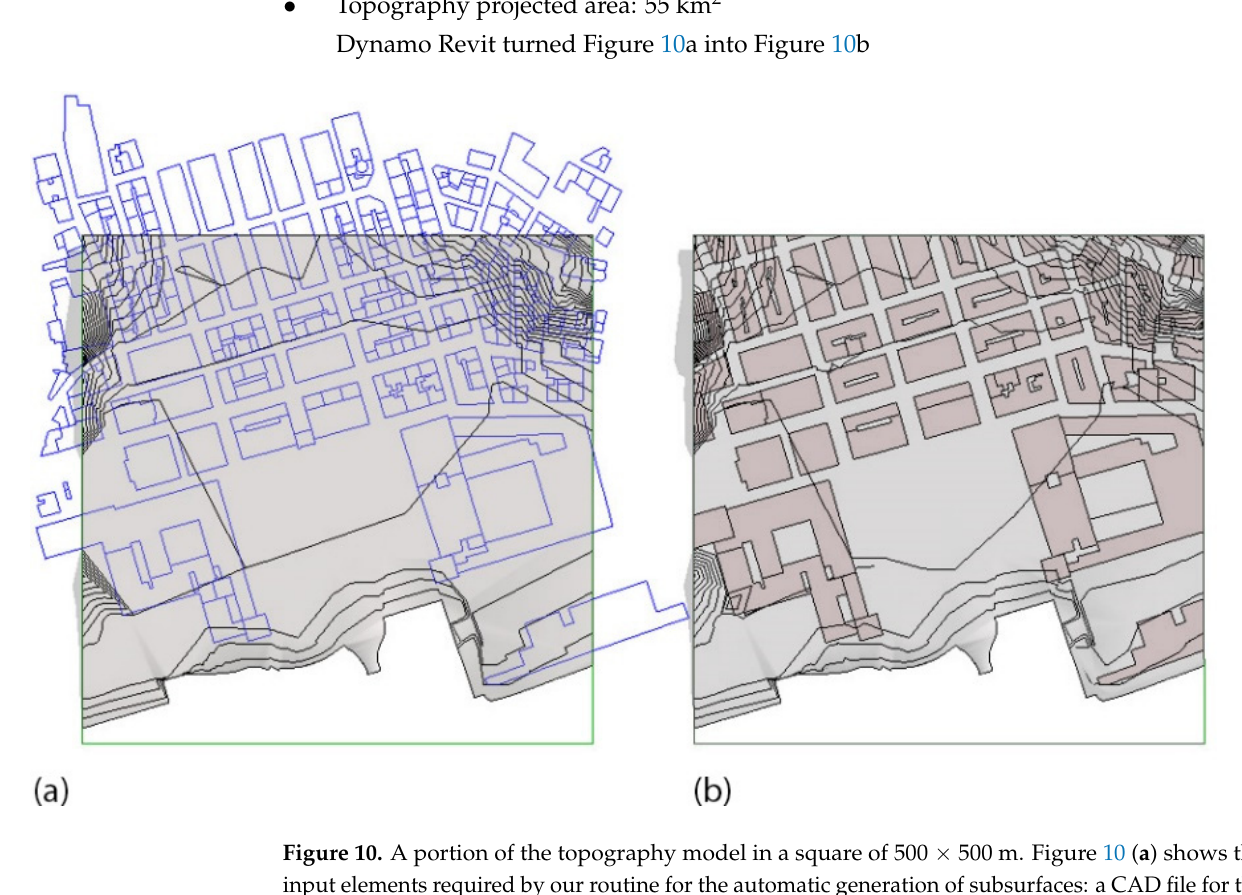
Figure 10. A portion of the topography model in a square of 500 × 500 m. Figure 10 ( a ) shows the